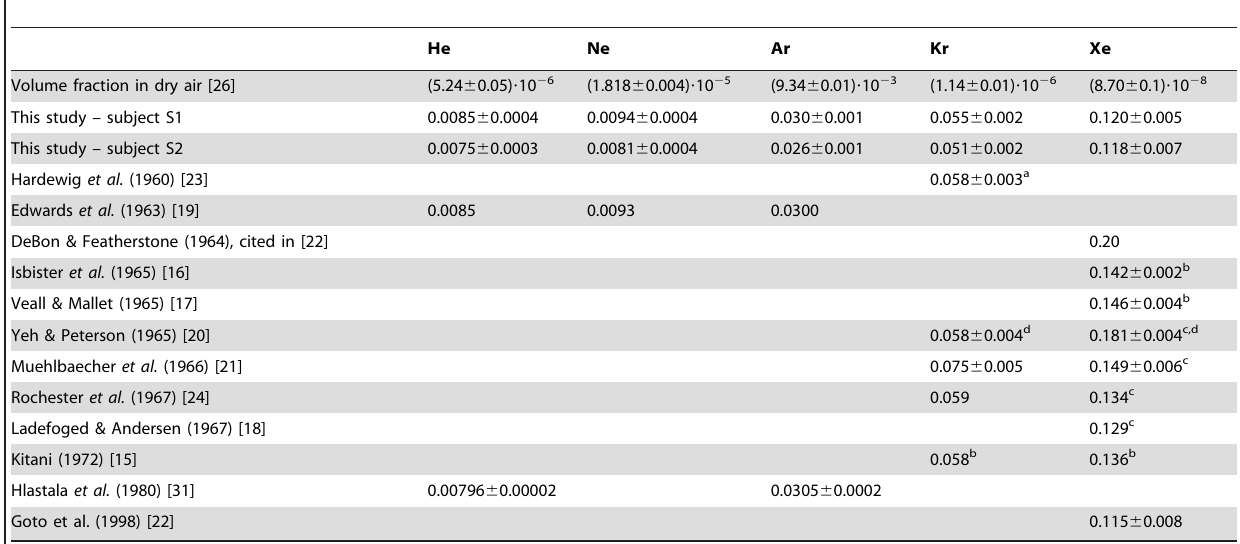
Table 1. Noble-gas partition coefficients between whole blood and air as determined in this study for two subjects (S1 and S2) compared with values from the relevant